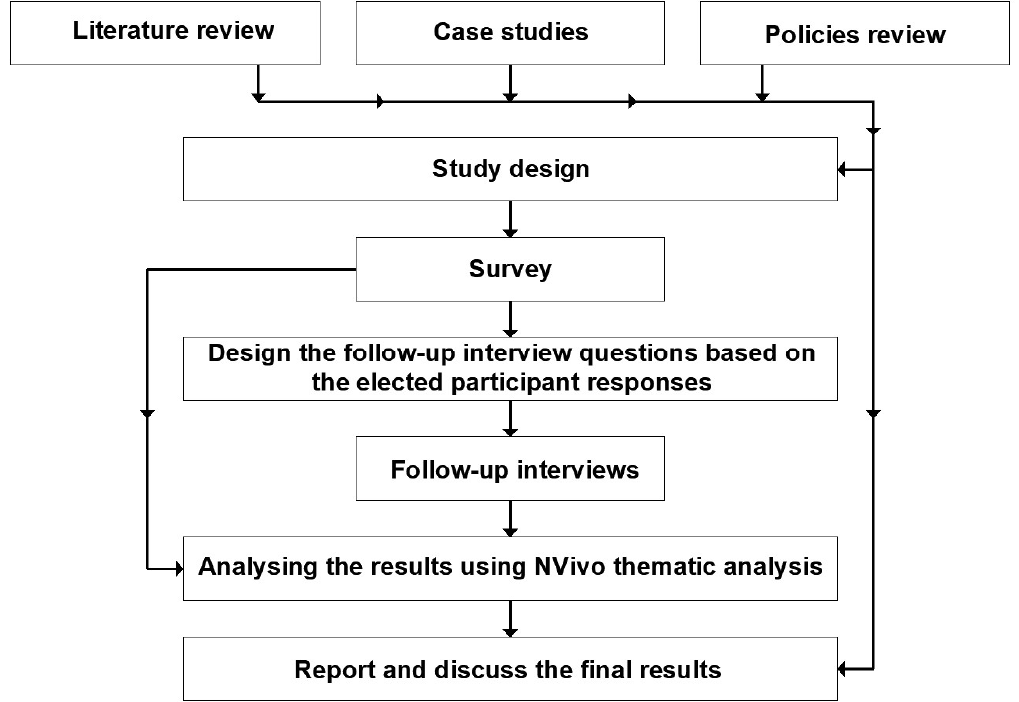
Figure 4. Research